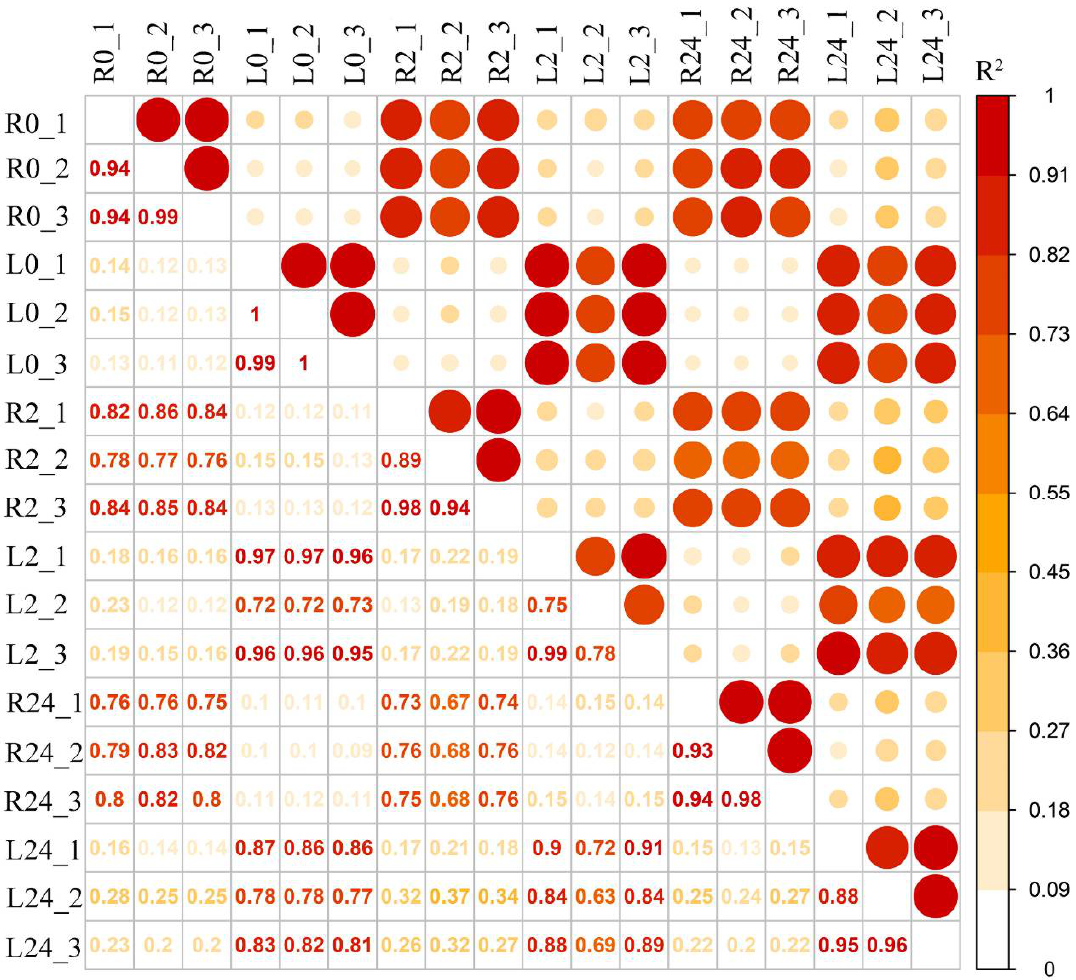
Figure 2. Pearson’s correlations between twelve samples. R 2 represents the coefficient of determination. An orange background represents a greater coefficient of determination (L0: leaf 0 h, R0: root 0 h, L2: leaf 2 h, R2: root 2 h, L24: leaf 24 h, R24: root 24 h).